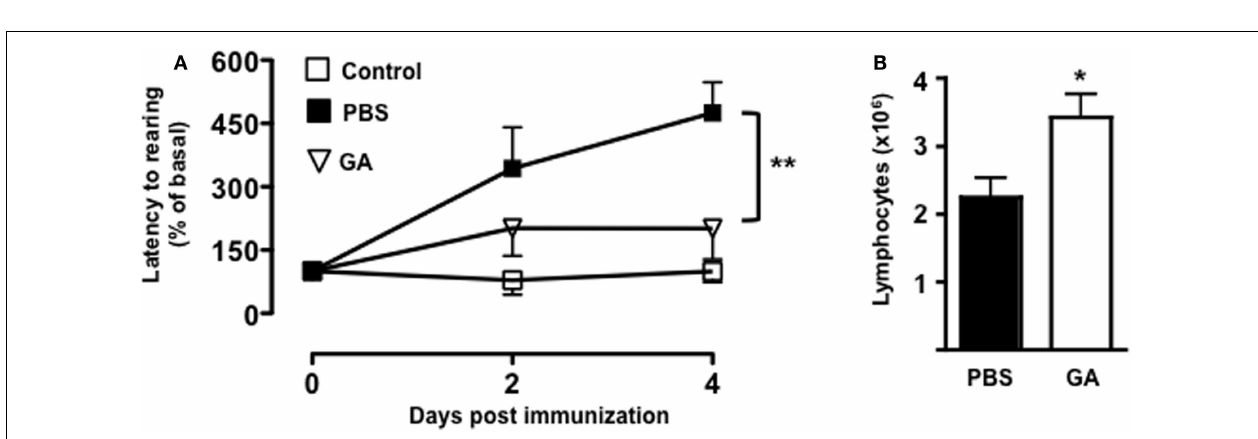
FIGURE 5 |The increase in latency to rearing relies onT cell antigenic stimulation .The graph in (A) shows the percentage of latency to rearing of control, CFA only or OVA 323–339 -immunized mice.Values are expressed as mean percentage ± SEM of the basal activity for eight to nine mice.The dot